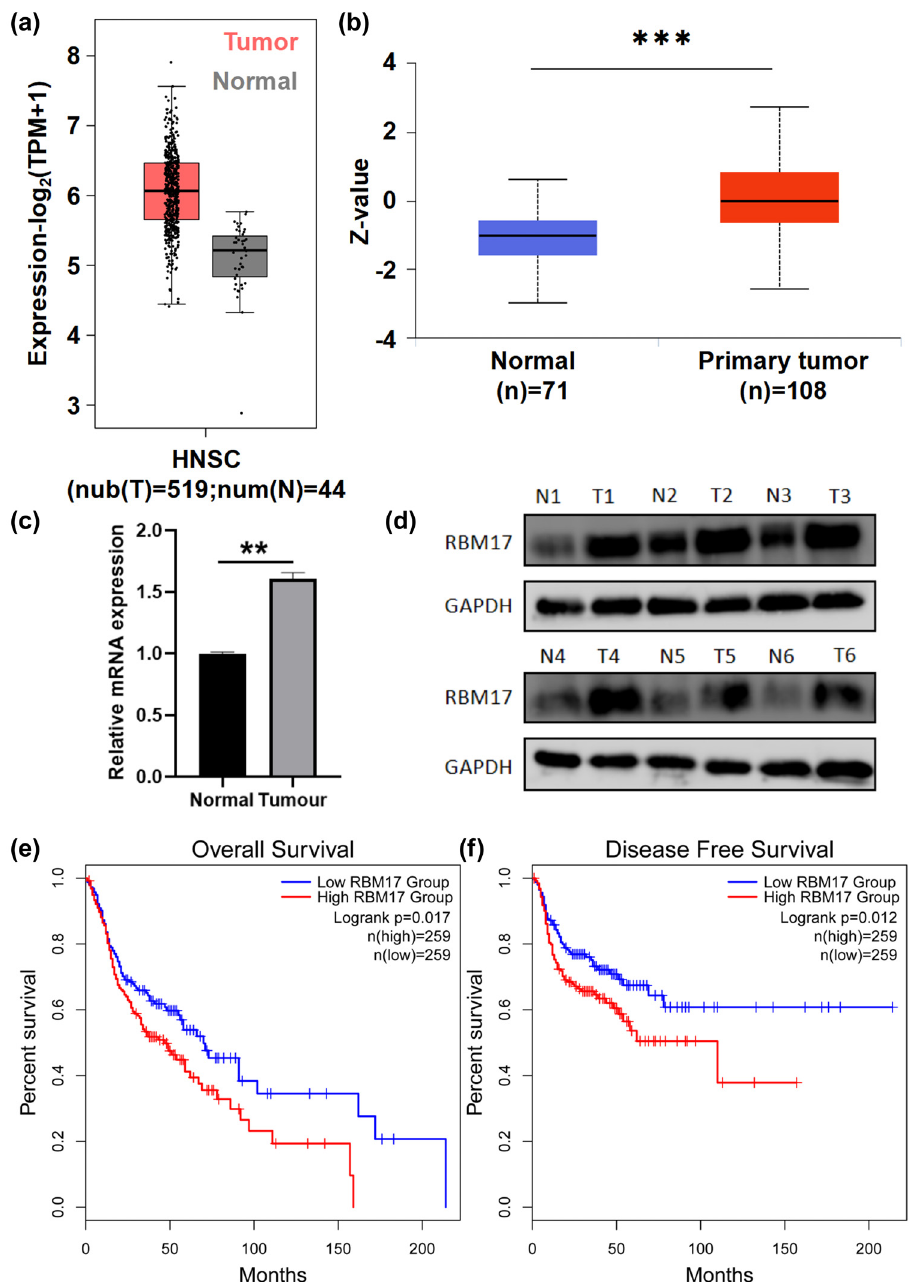
Figure 1: RBM17 is upregulated and associated with a poorer prognosis in HNSCC. ( a ) The expression of RBM17 in the TCGA database was compared with the expression of the corresponding normal tissues in the GTEx database, which was analyzed by GEPIA. ( b ) The protein level of RBM17 in primary tumor tissues and normal tissues from CPTAC database. ( c and d ) Expression level of RBM17 was con fi rmed by qRT - PCR and western blot in HSCC tissues and normal tissues. ( e and f ) Kaplan – Meier survival curve analysis of RBM17 for the OS and DFS in HNSCC from GEPIA database. ** P < 0.01, *** P <